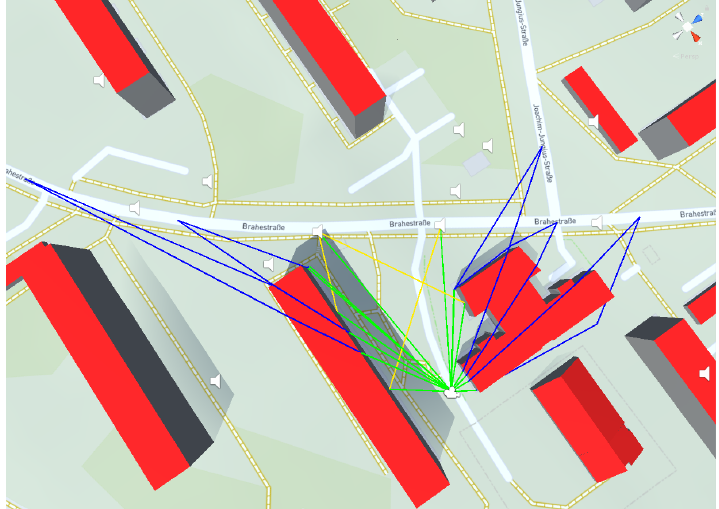
Figure 3. Noise propagation in a street with one observer point and seven source points. Green lines are direct paths and path end segments. Blue represents paths that lead to diffraction around buildings, and yellow paths that cause reflections on vertical building surfaces. The white speaker symbol shows the image sources vertically projected to the ground. (Otherwise, some would end up above the camera.) The observer is represented by a camera, the source points are located at the beginning of the line